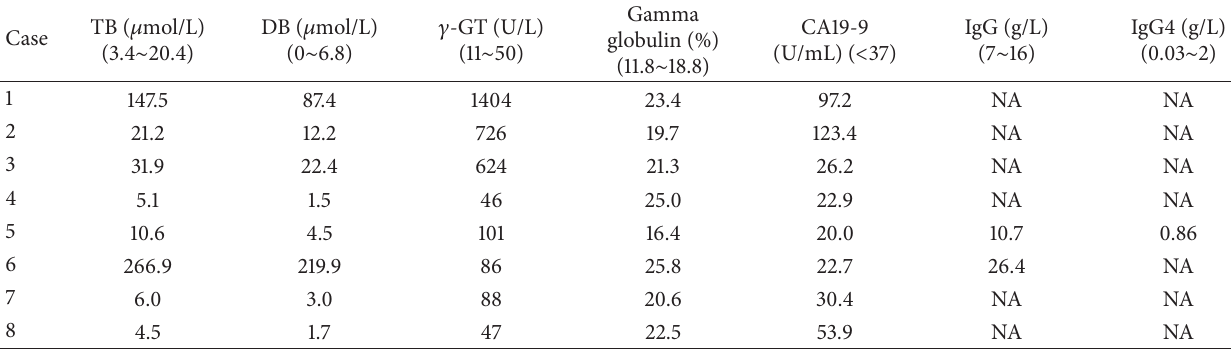
Table 2: Serological tests of AIP